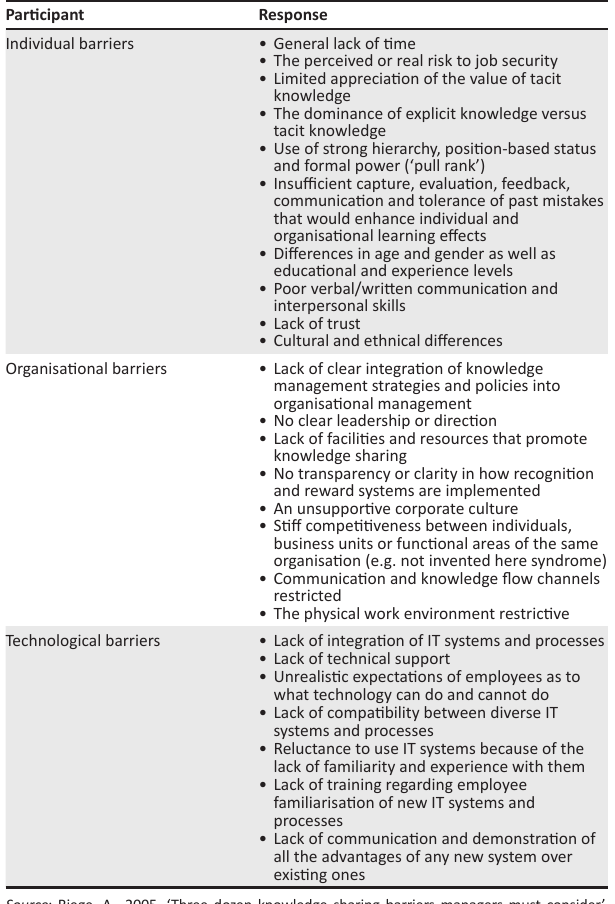
TABLE 1: Summary of barriers to tacit knowledge